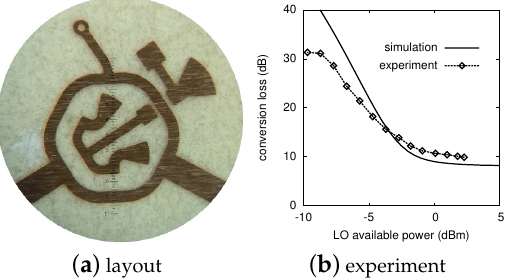
Figure A3. Manufactured layout ( a ) and experimental results ( b ) of the Schottky diode mixer. No components are soldered to the printed circuit board (PCB) shown in ( a ). The active area of the structure is about 4.6mm in diameter. Measured and simulated conversion loss are compared in the plot; these results are obtained by sweeping the LO power between − 10dBm and 5dBm with f RF = 24GHz, f LO = 23.95GHz, f IF = 50MHz, and P RF = − 30dBm. After Reference